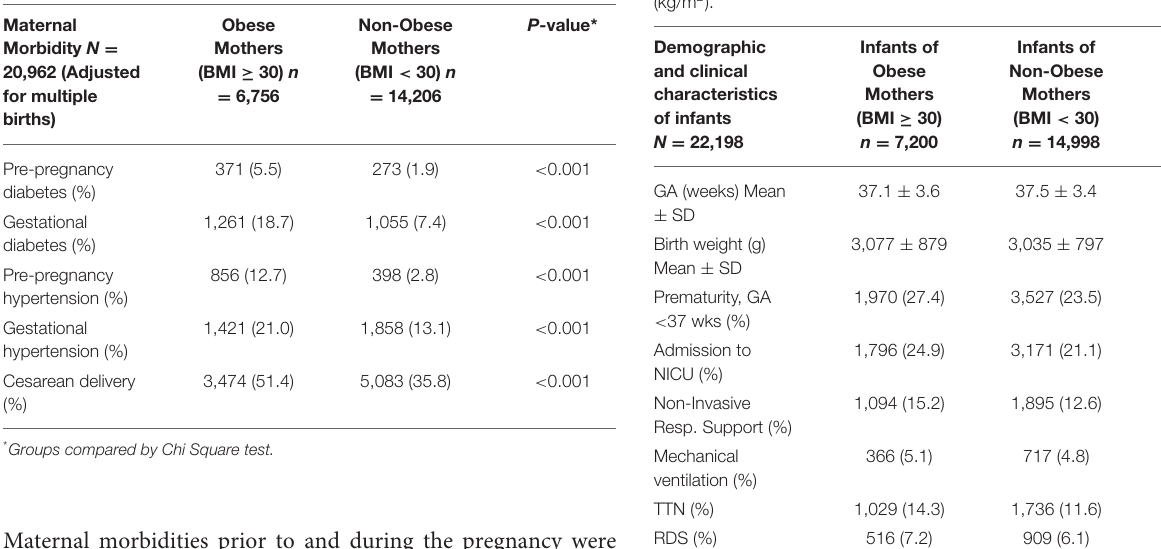
TABLE 1 | Maternal Morbidity by Body Mass Index (BMI) as kg/m 2 . TABLE 2 | Infant demographics and Early Neonatal Morbidity by Maternal BMI